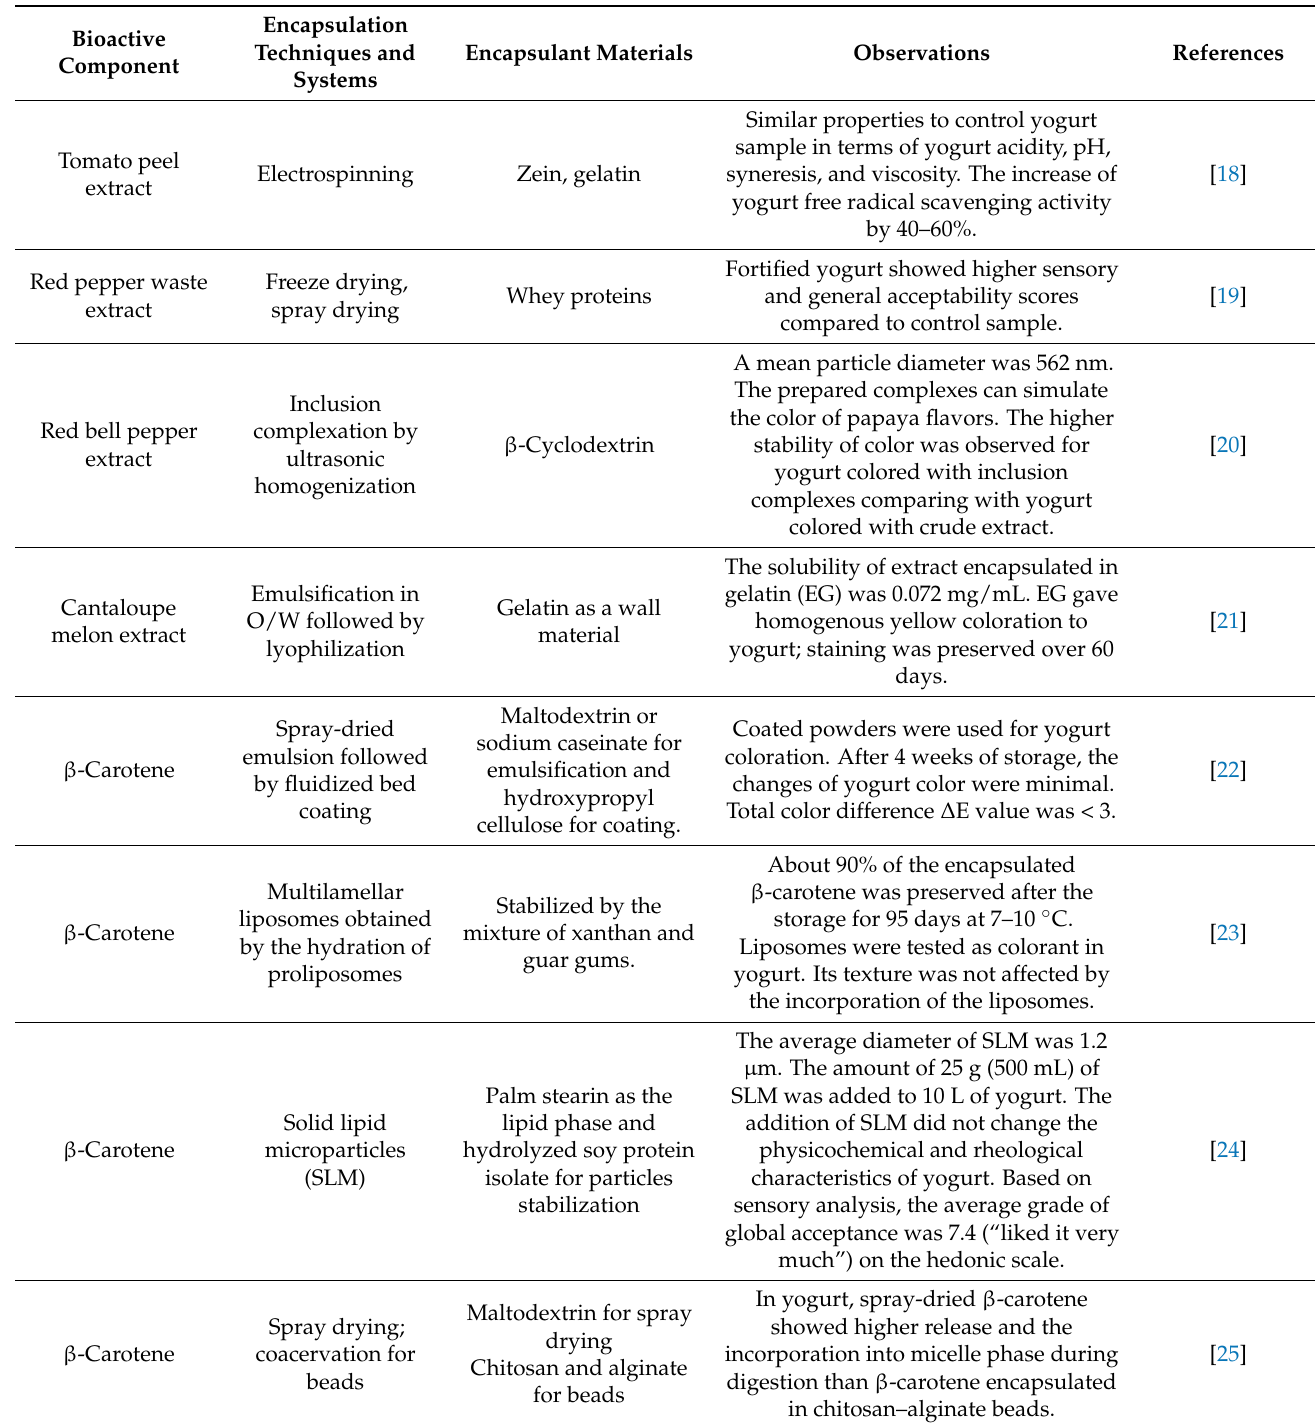
Table 1. Encapsulation of carotenoids and carotenoids containing components for yogurt’s